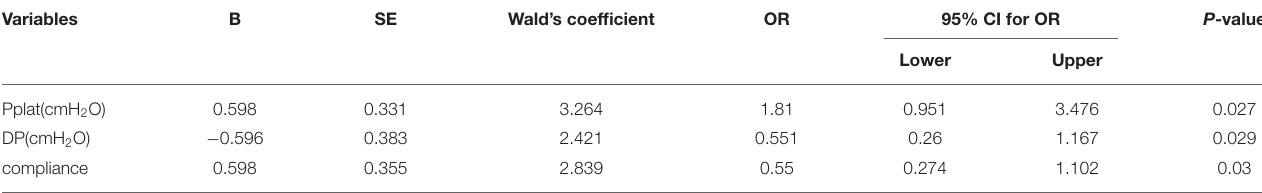
TABLE 3 | Multifactor logistic regression analysis for unsuccessful weaning risk factors. Variables B SE Wald’s coefficient OR 95% CI for OR P -value